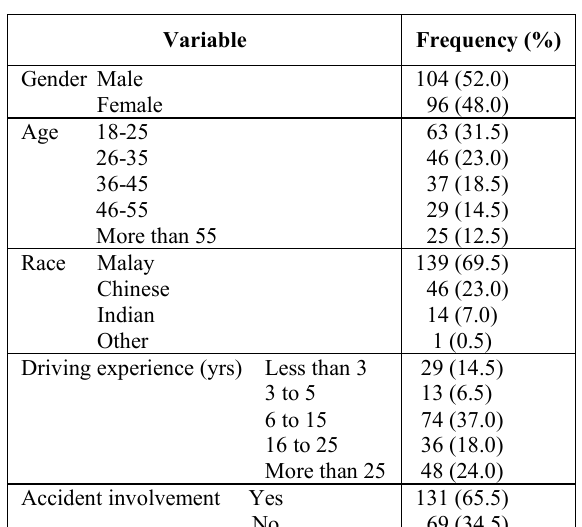
Table 1. The drivers’ profile